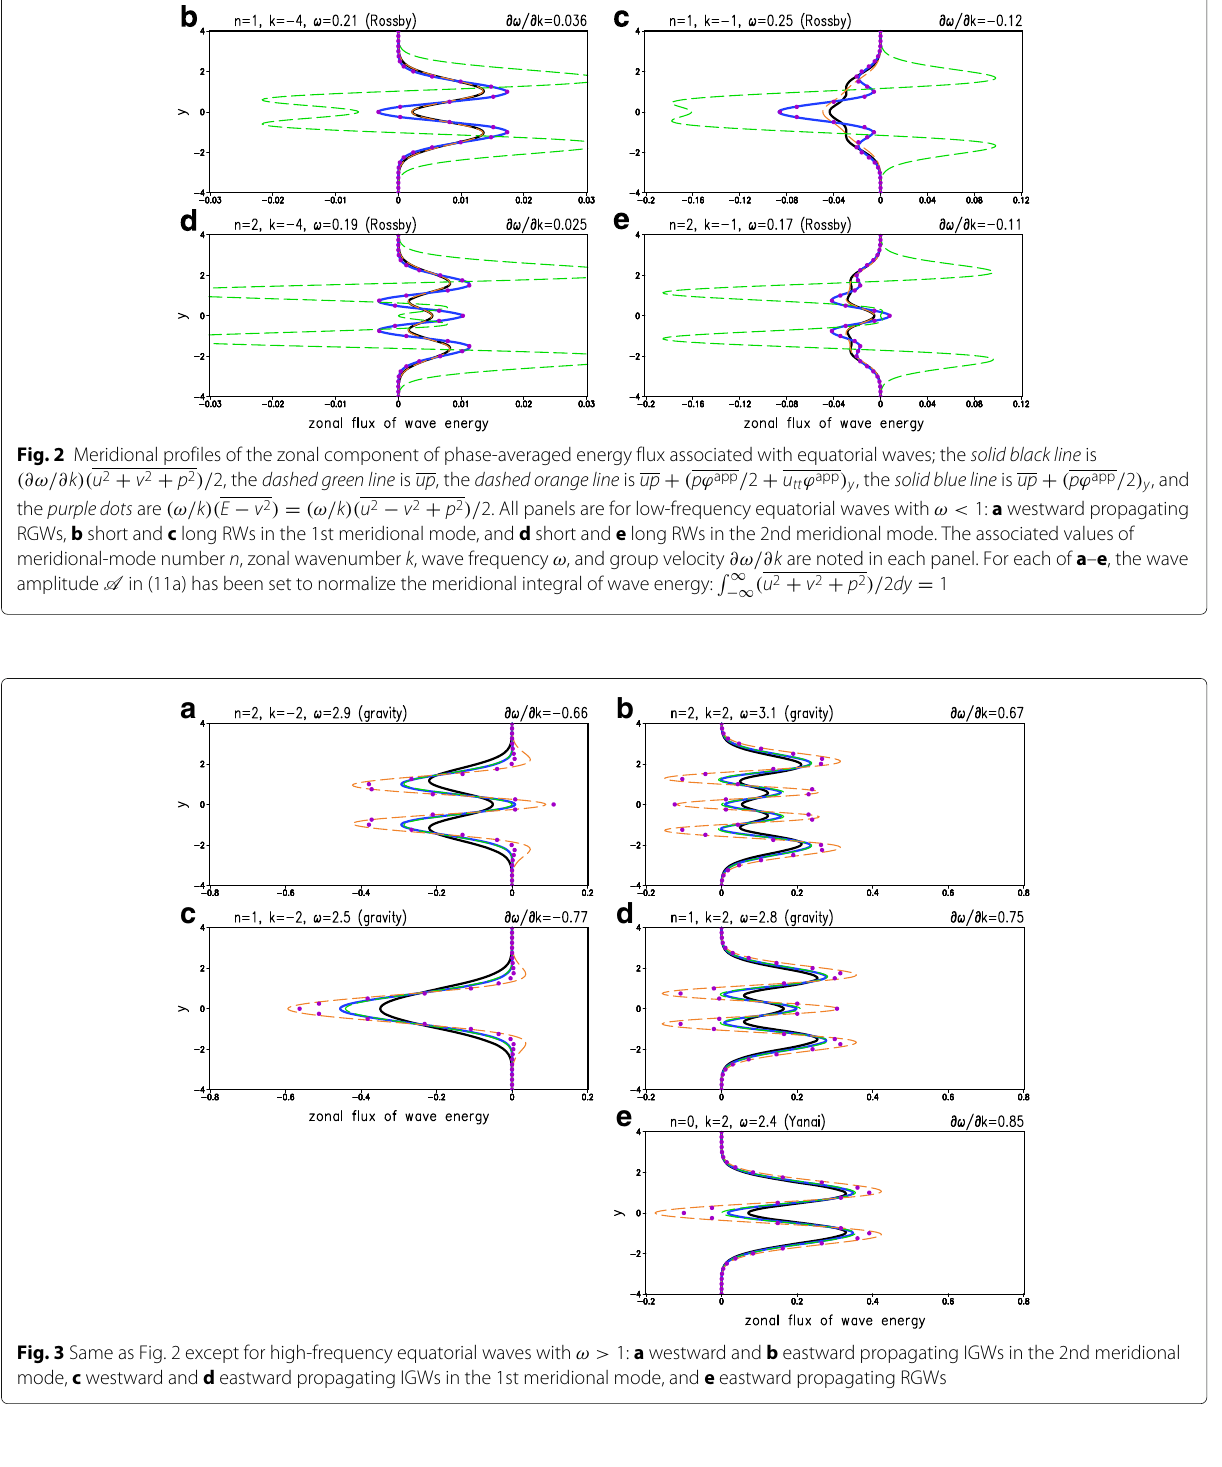
Fig. 3 Same as Fig. 2 except for high-frequency equatorial waves with ω > 1: a westward and b eastward propagating IGWs in the 2nd meridional mode, c westward and d eastward propagating IGWs in the 1st meridional mode, and e eastward propagating